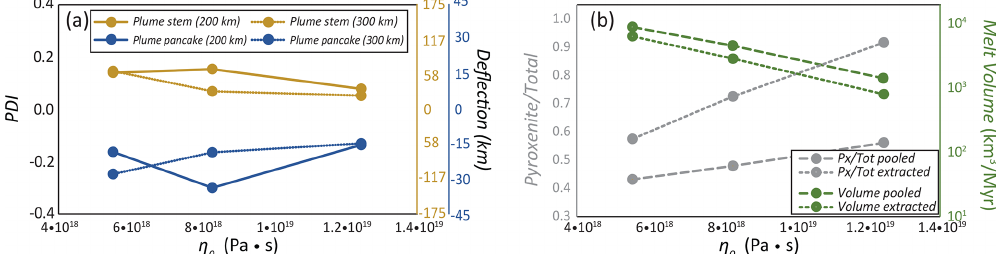
Figure 9. Diagrams showing the sensitivity of selected output parameters to η 0 in the steady state. Note that the PDI change is different for different D plume